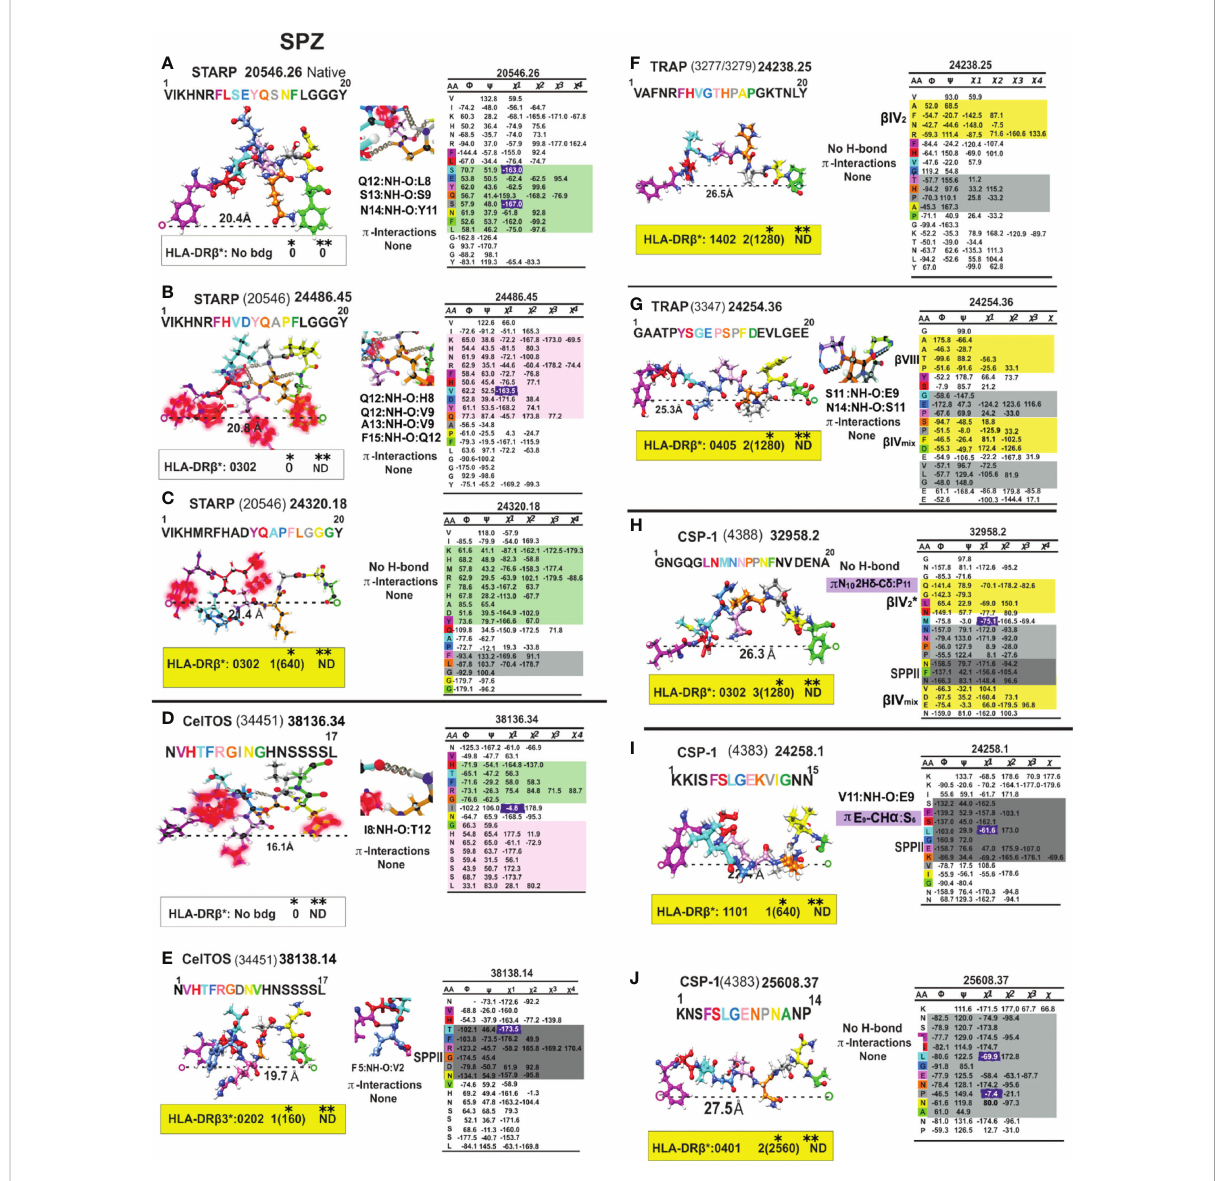
FIGURE 12 Colour code for peptide binding region, structural and interaction as in Figure 8. (*) Nr Monkeys (antibody titers) and (**) Nr of protected monkeys. STARP-, CelTOS-, TRAP- and CSP-1-derived cHABPs and mHABPs. Legend and conventions as in Figure